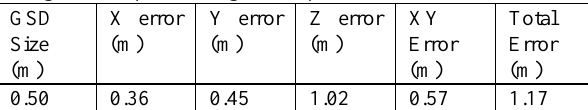
Table 3: Errors the geometric parameters of the hyperspectral images in the phototriangulation